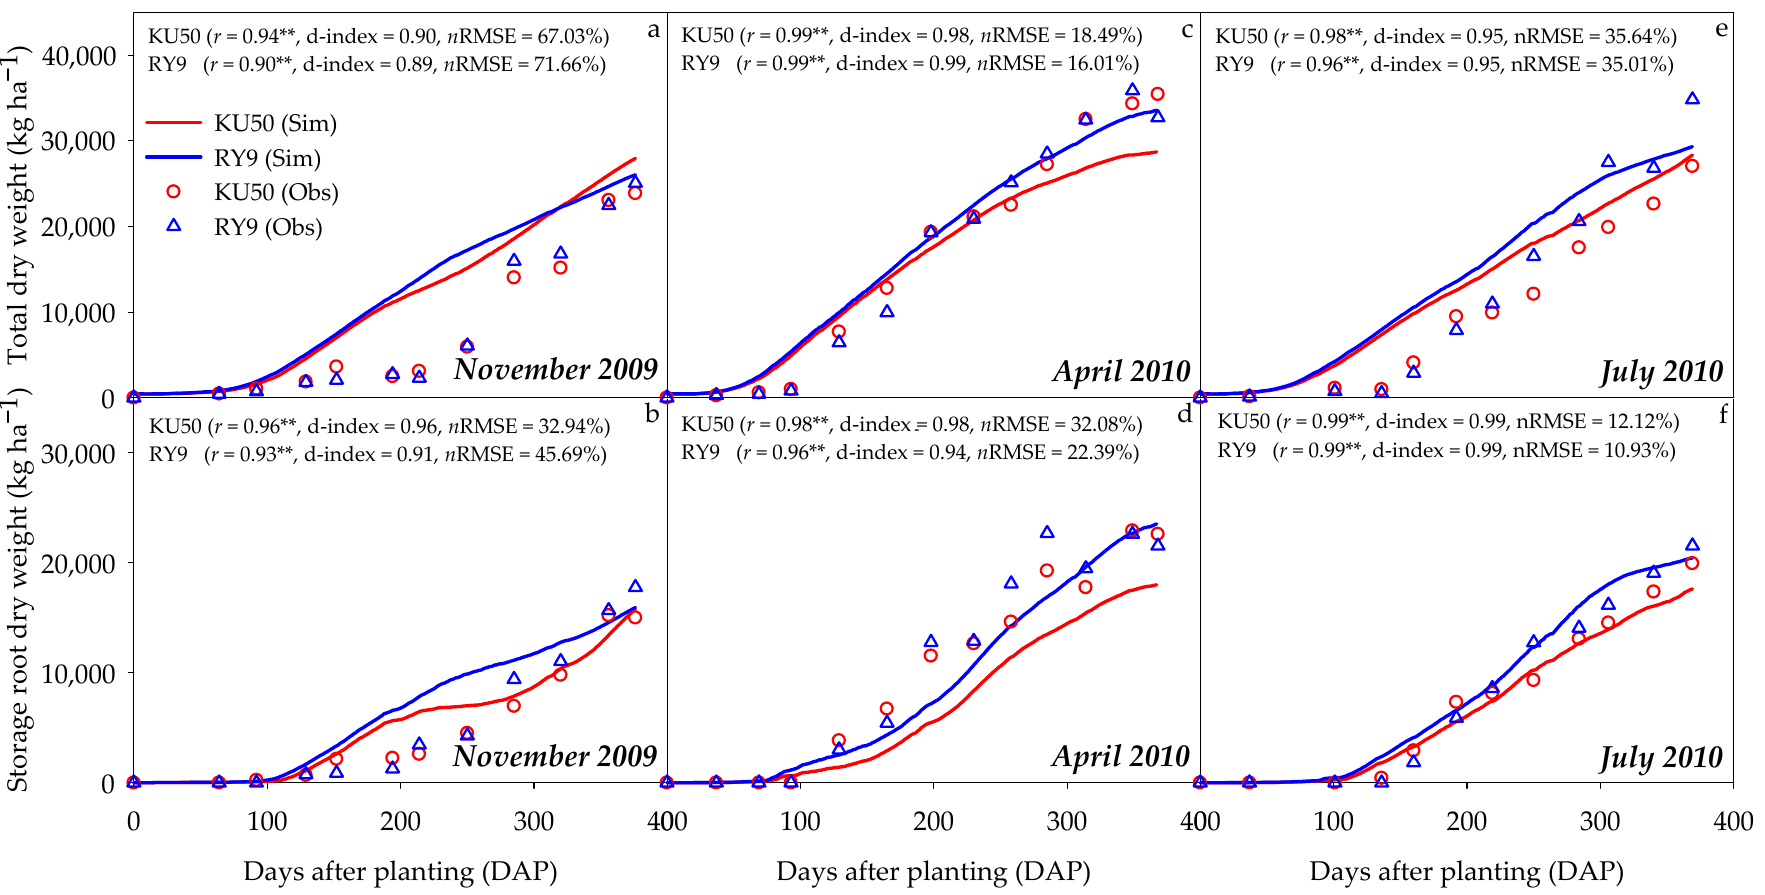
Figure 2. Simulated (Sim) and observed (Obs) total and storage root dry weights for Kasetsart 50 (KU50) and Rayong 9 (RY9) genotypes planted at November 2009 ( a , b ), April 2010 ( c , d ), and July 2010 ( e , f ). r = Pearson correlation coefficient, d–index = index of agreement, n RMSE = normalized root mean square error, ** = significant at p ≤ 0.01.